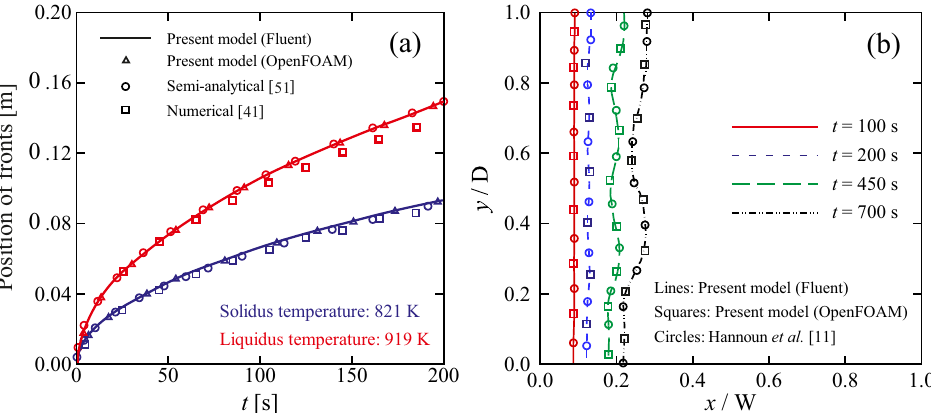
Figure 2. Code validation and solver verification. ( a ) One-dimensional benchmark problem; time evolution of the mushy-zone thickness (blue: solidus; red: liquidus) predicted by the present model implemented in Fluent and OpenFOAM compared with available semi-analytical [51] and numerical [41] results. ( b ) Two-dimensional benchmark problem; time evolution of solid–liquid interface during isothermal phase-change with convection predicted by the present model implemented in Fluent and OpenFOAM compared with numerical results of Hannoun et al.